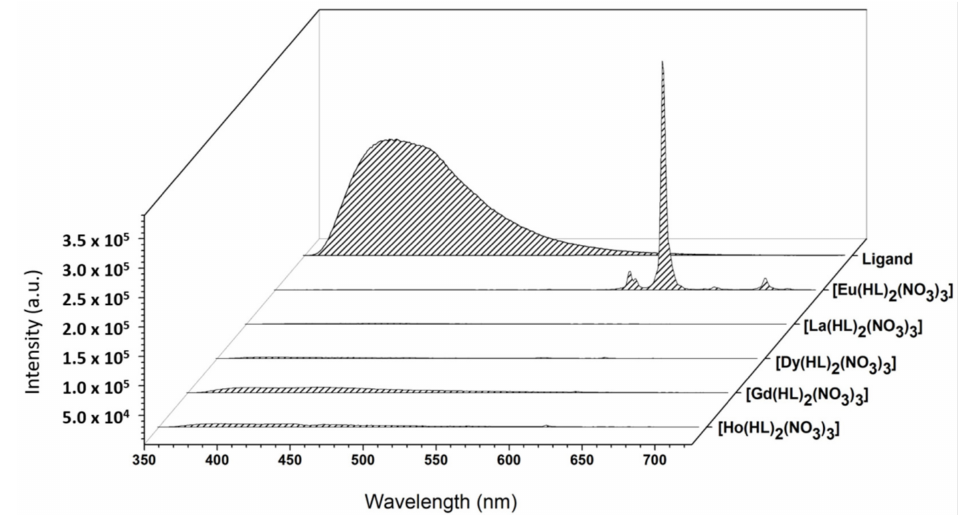
Figure 4. Emission spectra of five complexes and ligands obtained under excitation at 315